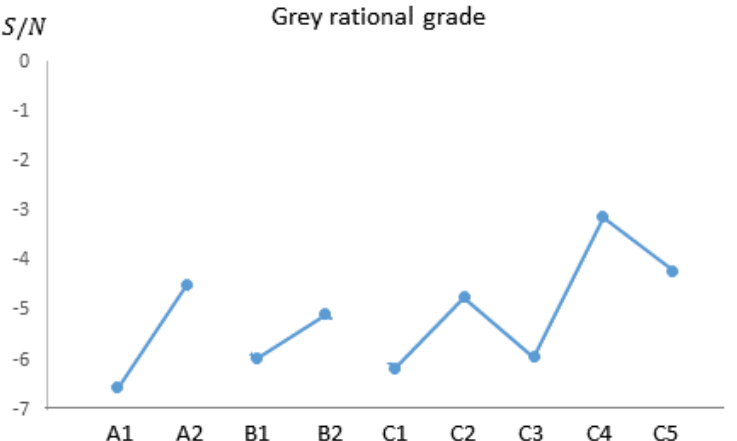
Figure 3. The graph of marginal S / N ratio for all levels of the factors when the performance criterion is considered.